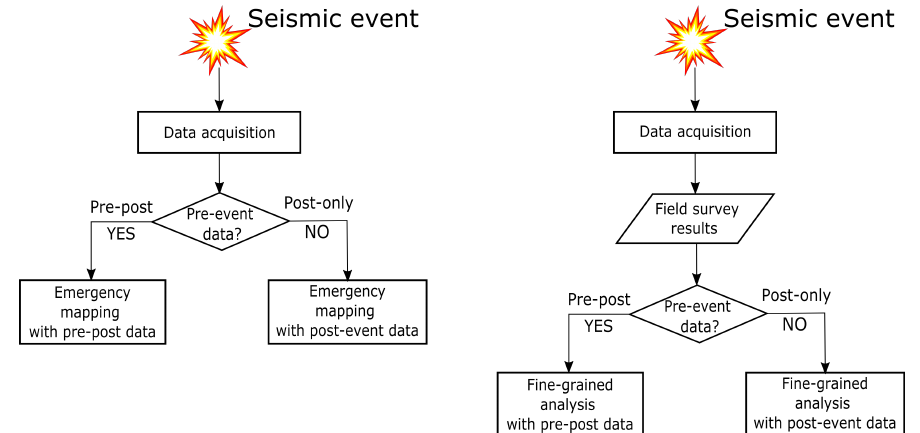
Figure 6. Overall damage detection framework of emergency mapping (left) and fine-grained analysis